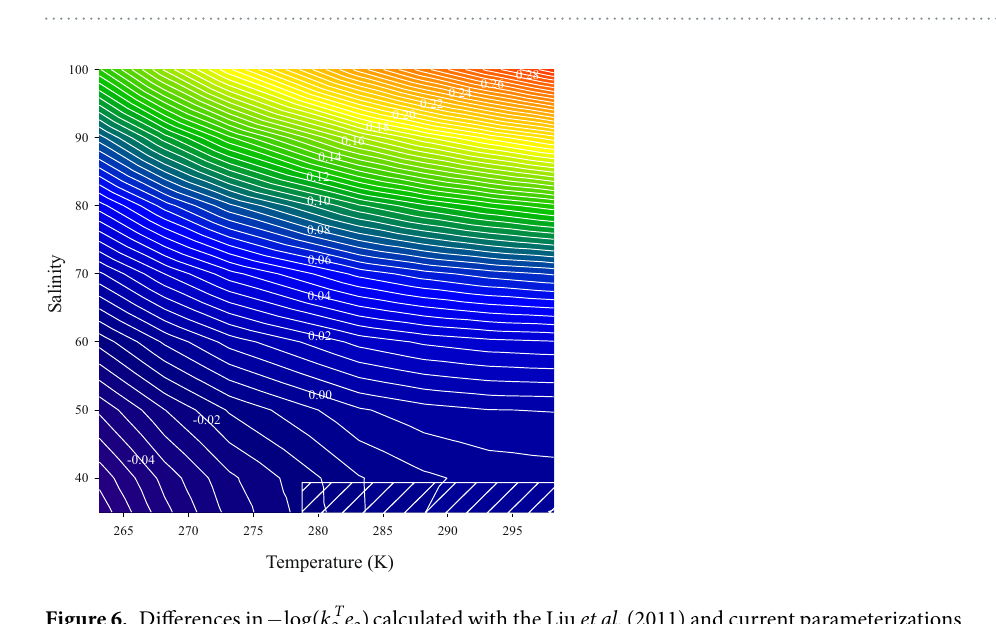
Liu et al . 31 determined the − k e log( ) T of purified m CP for 278.15 ≤ T ≤ 308.15 and S = 20–40. Our − k e log( ) T 2 2 2 2 S-T parameterization (equation 9) and that in Liu et al . 31 yield values within 0.001 at S = 35 and T = 298.15 ± 5 K and within 0.010 down to T = 283.15 K. Higher discrepancies between the two relationships at low temperatures (Fig. 6) may reflect differences between the instruments used for the − k e log( ) T determination. The pH measur- 2 2 ing system used for this work had no parts of the optical path exposed to air, thus eliminating the possibility of condensation at low temperatures. The condensation is more difficult to control with bench-top spectrophotom- eters as that used by Liu et al . 31 , although dry N 2 gas was used to eliminate condensation on the optical windows at 5 °C. From this comparison, it is clear that the relationship for − k e log( ) T by Liu et al . 31 should not be extrapo- 2 2 lated for pH measurements outside its range (S = 20–40, T = 278.15–303.15 K) as this can lead to large errors in pH (0.02–0.30) (Fig. 6). The relationship (equation 8) proposed here should also not be used outside its calibra- tion range (S = 35–100, T = 267.15–298.15 K).